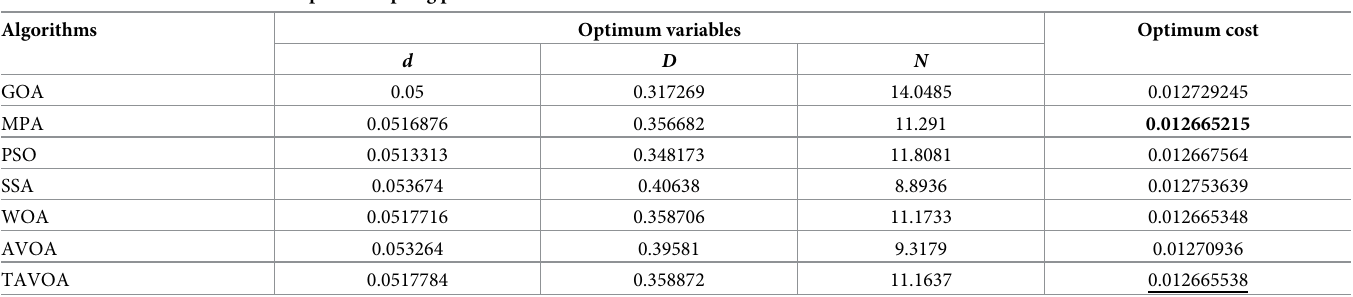
Table 15. Best results of tension/compression spring problem.